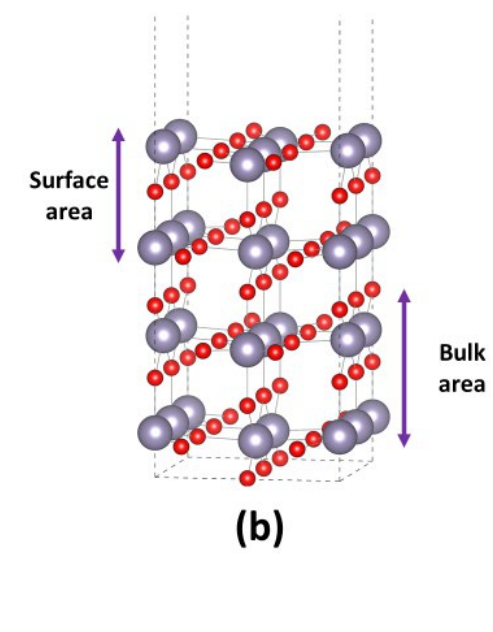
Figure 5. The refractive index of ( a ) Sn i : SnO 2 and ( b ) V o : SnO 2 .